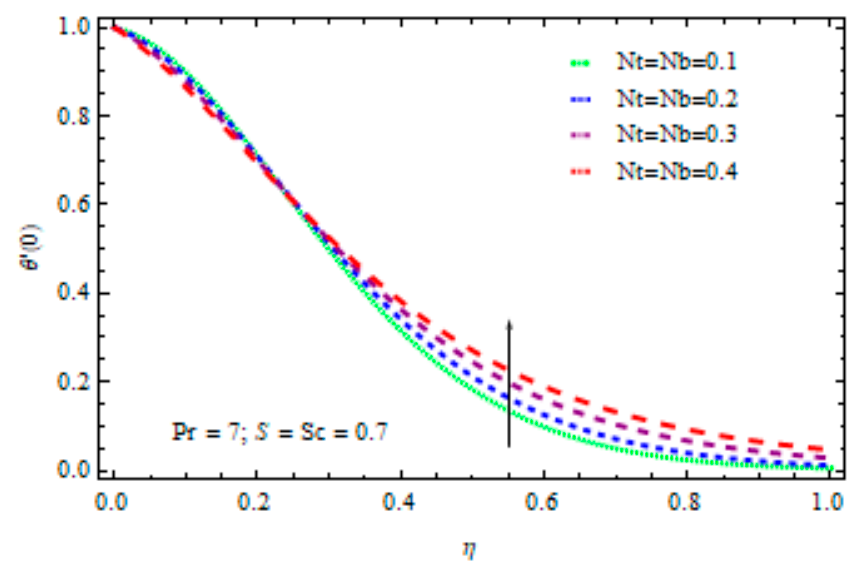
Figure 17. The impact of the